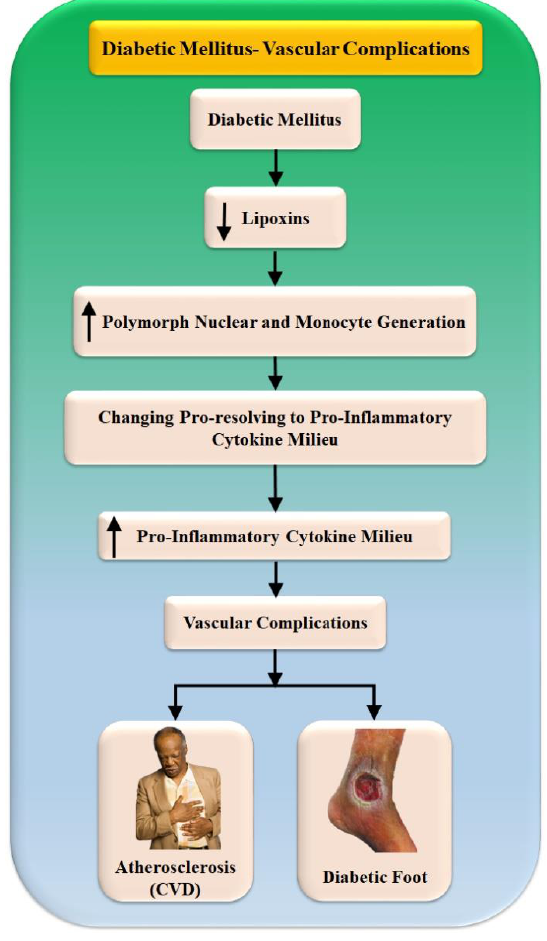
Figure 4. Vascular complications due to diabetes mellitus. As altered gene expression patterns and signaling pathways combine with immune cells, blood vessel cells malfunction, increasing the risk of vascular and cardiovascular disease in patients with certain metabolic abnormalities [26].